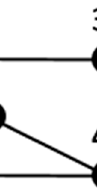
Figure 7. A 3-partite graph that is not a set intersection graph. Nodes labeled 0 and 1 in the leftmost partite set cannot both be singleton vertices, since otherwise nodes 2 and 3 must be adjacent. By the same token, nodes labeled 3 and 4 in the rightmost partite set cannot both be singleton vertices, else nodes 1 and 2 must be adjacent. But node 2 in the middle partite cannot be a singleton vertex either, because that would require nodes 0 and 4 to be adjacent.